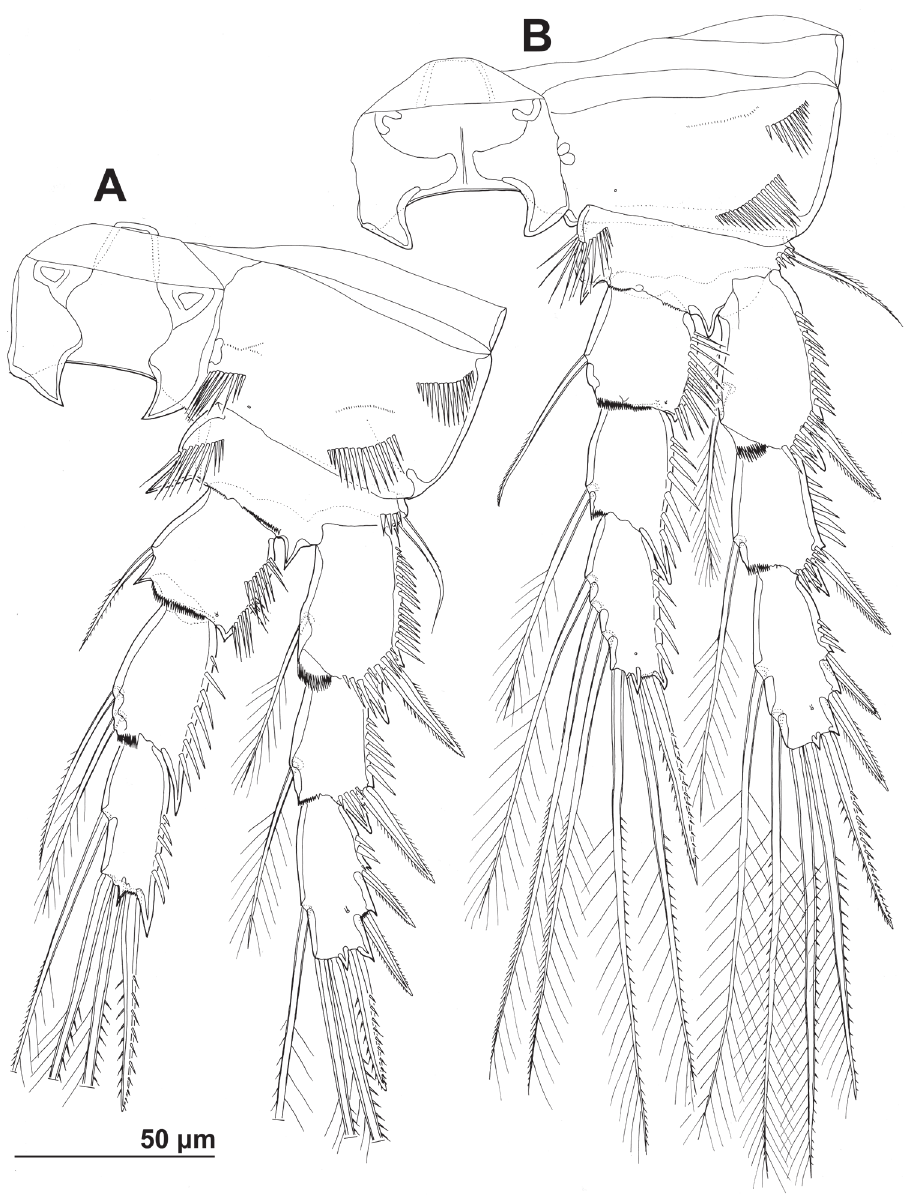
Figure 6. Stenhelia pubescens Chislenko, 1978, line drawings, female 3: A second leg, anterior B third leg,